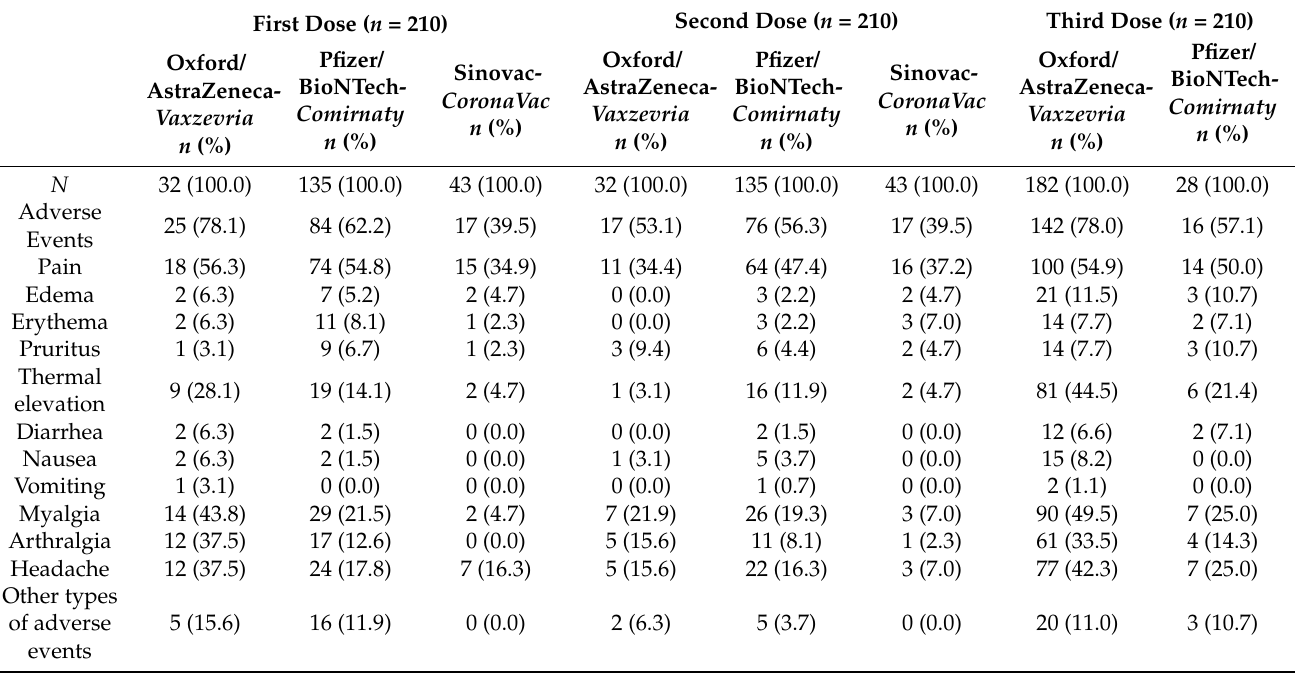
Table A2. Descriptive characteristics of adverse events in relation to the dose and